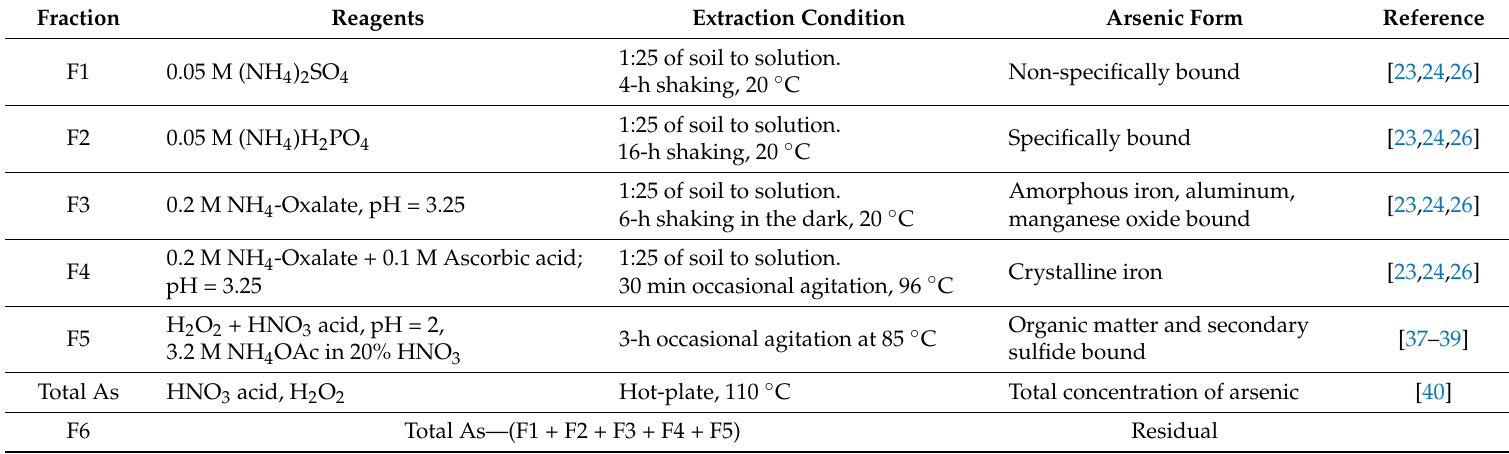
Table 1. Modified sequential extraction scheme for arsenic in soils used in this